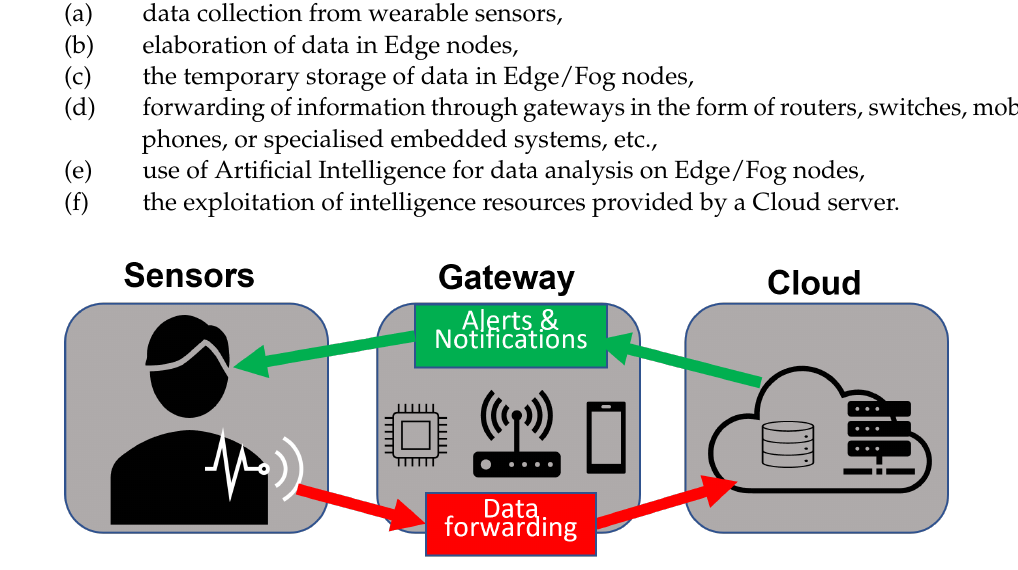
Figure 1. Typical Cloud-based